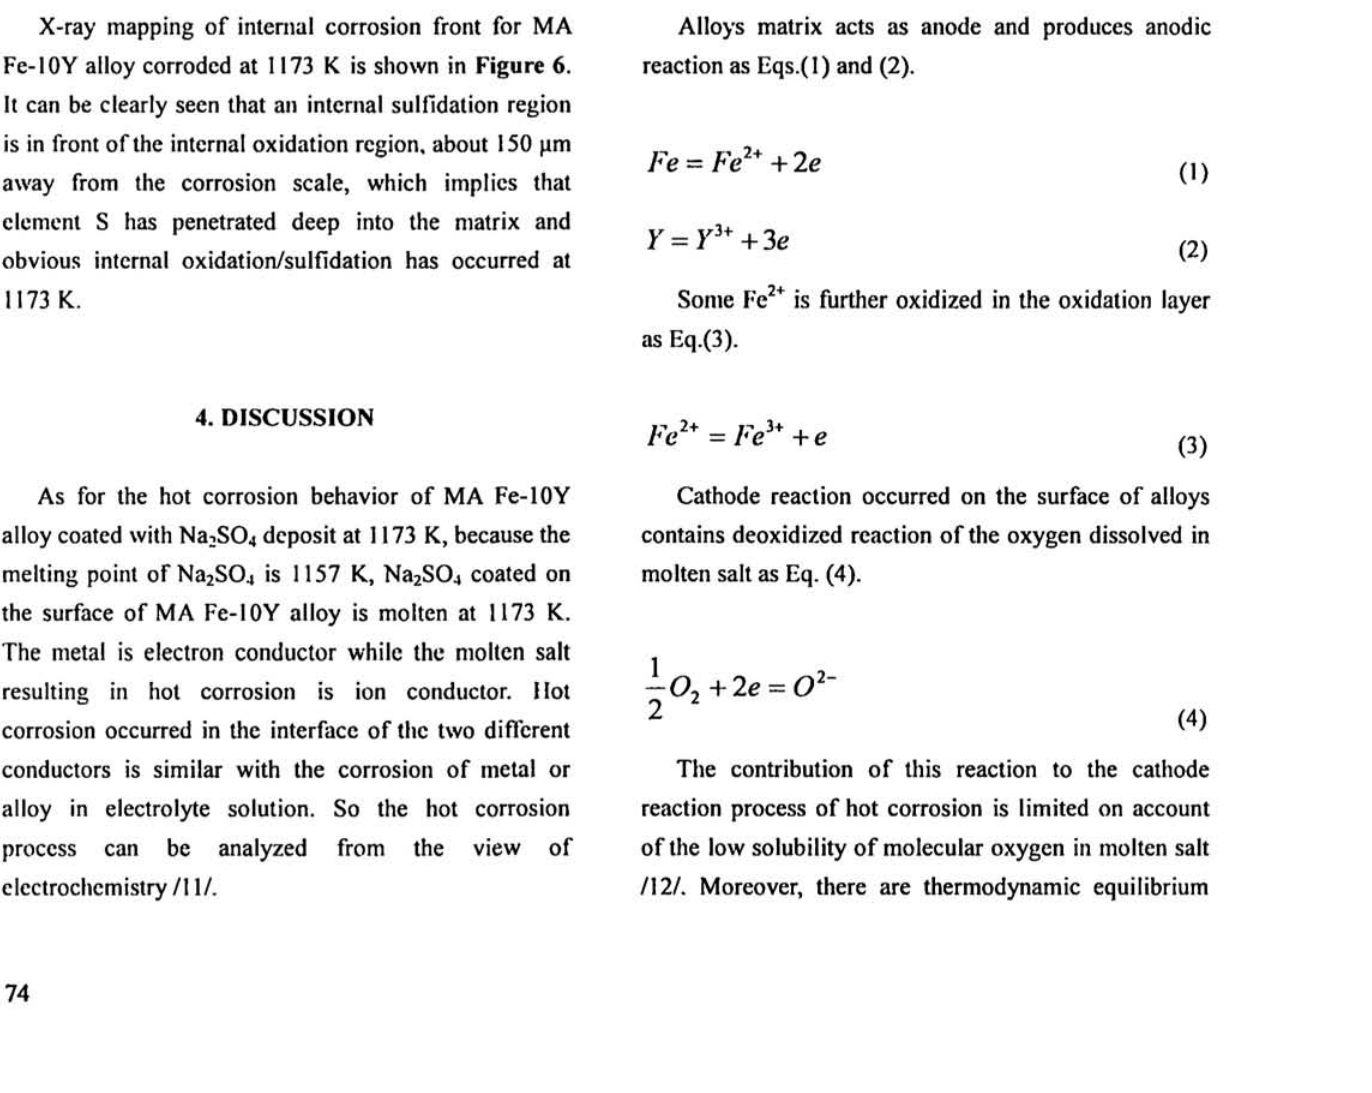
Fig. 6: X-ray mapping of internal corrosion front for MA Fe-10Y alloy corroded at 1173 K is shown in Figure